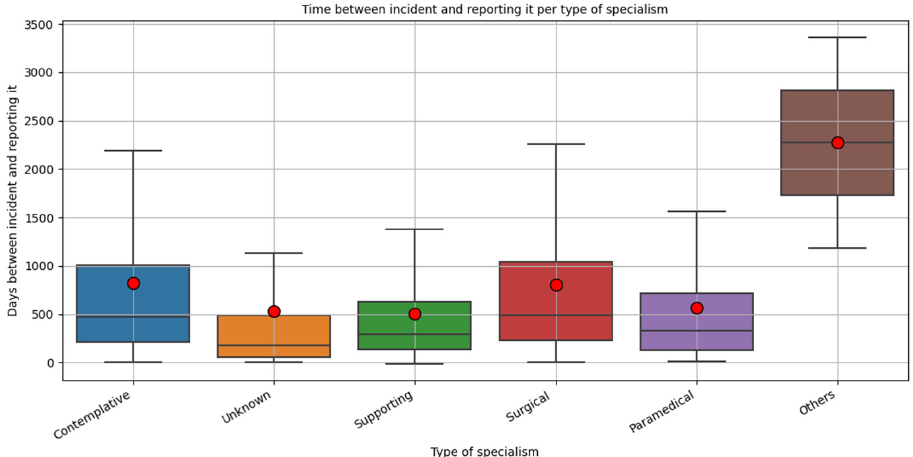
Figure 2. Time between incident and submission of malpractice claims (days). The boxes reflect the first–third quartile. The black lines in the boxes represent the median amount of days between incident and claim submitted. The red dots indicate the mean amount of days.